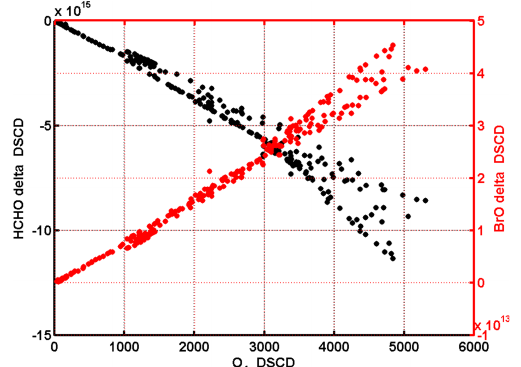
Fig. 14. Change in retrieved HCHO (black) and BrO DSCDs (red) (delta dDSCDs=dDSCD (new setting) − dDSCD (baseline); in moleccm − 2 ) when exchanging the Hermans et al. (2003) O 4 absorption cross section for the Greenblatt et al. (1990) data set, expressed as a function of the O 4 DSCD values (in 10 40 molec 2 cm − 5 ).